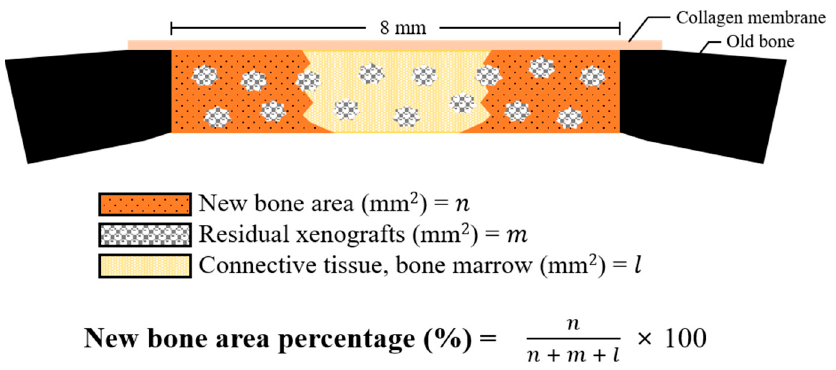
Figure 3. Schematic diagram of histometric analysis.